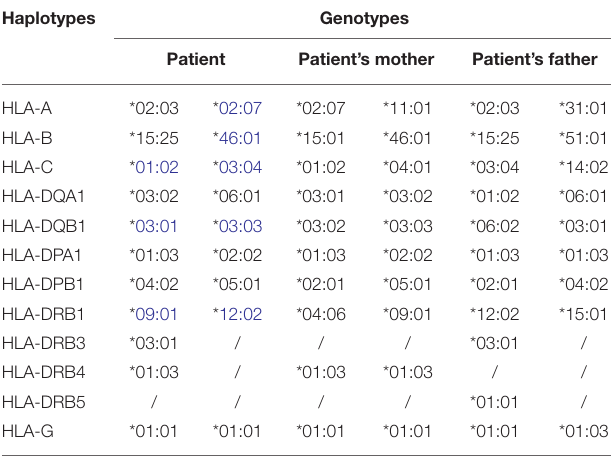
TABLE 1 | HLA genotypes of the patient and her